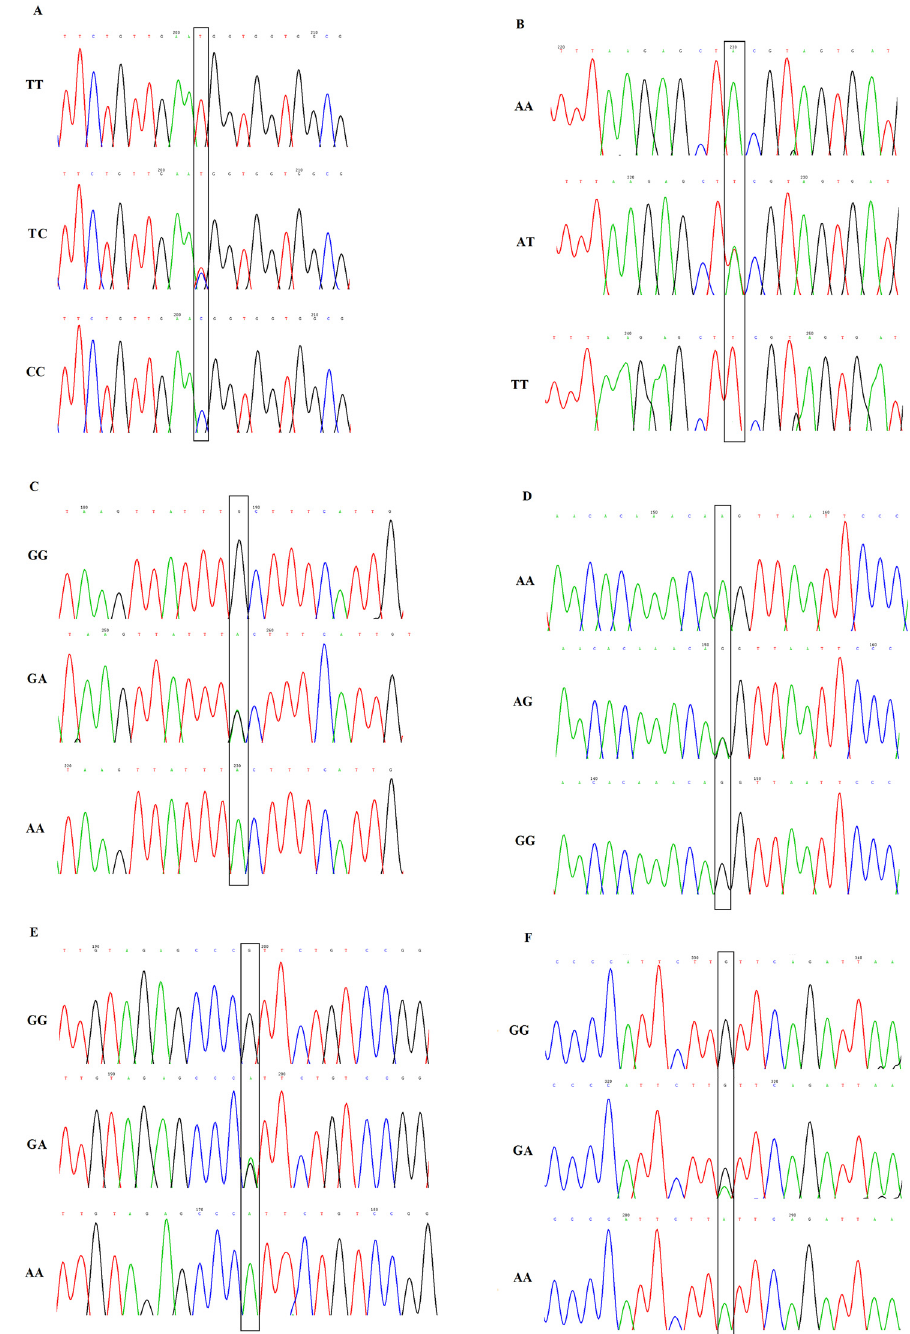
Fig 2. Representative figures of direct sequencing for the six SNPs of RAC1 gene. (A) rs836488, (B) rs702482, (C) rs10951982, (D) rs702483, (E) rs6954996, and (F) rs9374. Allelic variants were indicated by